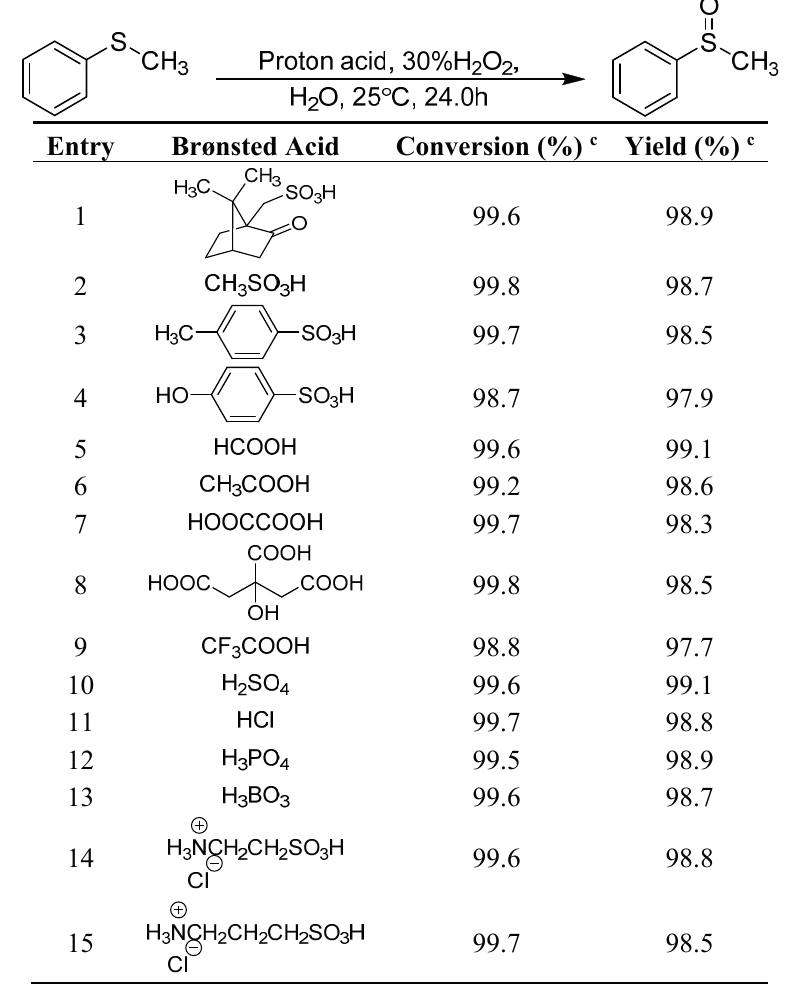
Table 4. Oxidation of methyl phenyl sulfide with H 2 O 2 catalyzed by Brønsted acids at pH 1.30 a,b